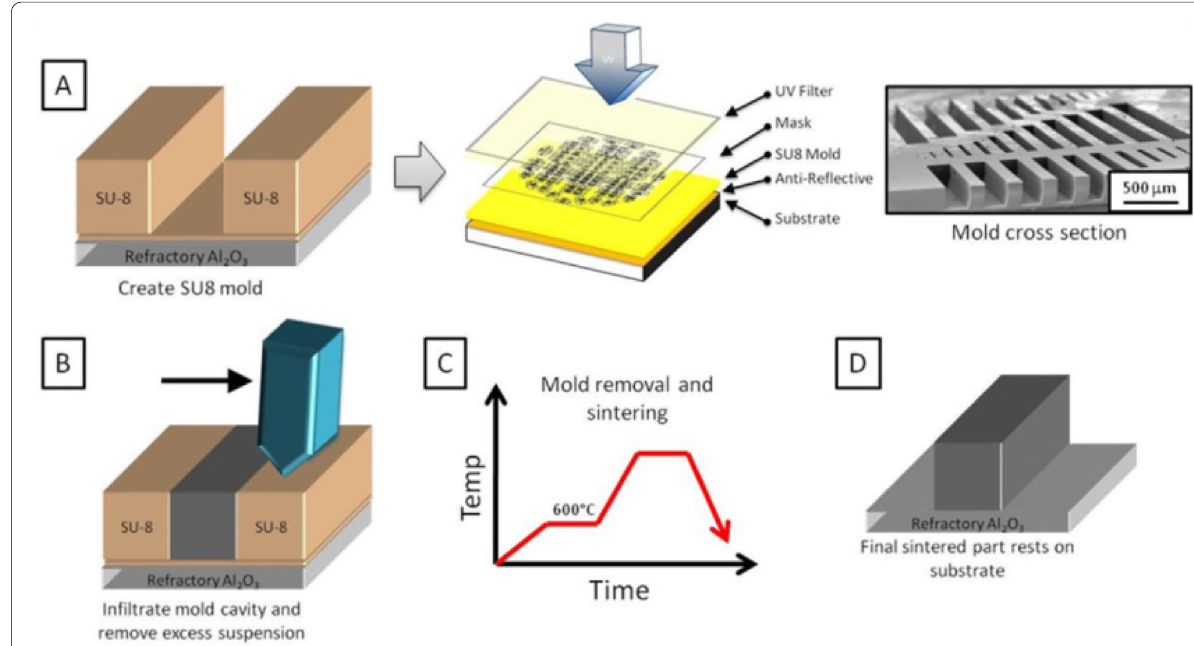
Figure 8 The steps of the LM-RIF process: ( A ) Molds are fabricated on high purity refractory substrate via patterning of SU-8 photoresist, ( B ) The fabricated molds are then infiltrated with a high solid loading colloidal suspension using a screen printing squeegee; ( C ) The combined mold removal and sintering form a dense final part; ( D ) Freestanding parts are left on the original substrate [80] (©Copernicus GmbH. Adapted by permission of Copernicus GmbH. Permission to reuse must be obtained from the